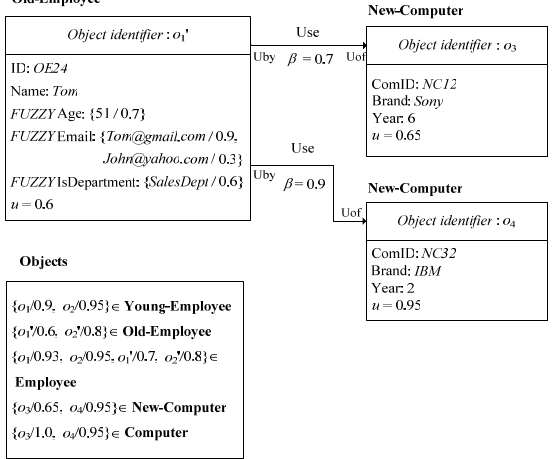
Fig. 8. A fragment of a fuzzy UML instantiation (i.e., object diagram) w.r.t. the fuzzy UML model F UML1 in Fig.